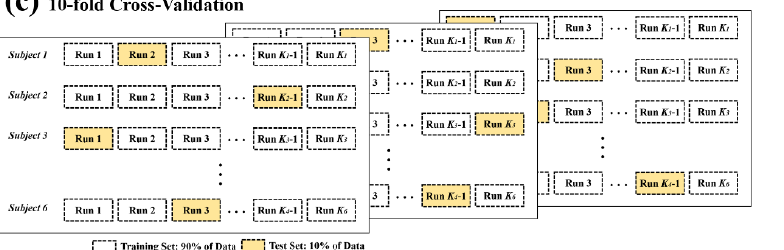
Figure 4. Data separation. ( a ) Within-subject validation was used to train and evaluate the individual classifiers on the attentive and resting states. One run was used for the test set, and the remaining runs were used for the training set. This process was repeated K times, and the test set was switched every time. The accuracy was averaged over K repetitions. ( b ) Cross-subject testing was performed. The data from one subject were used as a training set, and the data from the other 5 subjects were used as a test set. This process was repeated for each of subjects. ( c ) A generic classifier was evaluated using 10-fold cross-validation. The complete dataset from all subjects was collected and randomly split into a test set (10%) and a training set (90%). This process was repeated 10 times, with a different training set and a different test set each time. The accuracy was averaged over 10 repetitions. 3. Results 3.1. Classification Results The ESN had a single readout that indicated whether the subject was in an attentive state or a resting state. Because the attentive state was labeled 1 and the resting state was labeled -1, positive readout values were classified as an attentive state, and negative values were classified as a resting state. The classification performance was evaluated using three cross-validation schemes: Within- subject validation, cross-subject validation, and 10-fold cross-validation. Parameter optimization was performed by averaging accuracies obtained from 10 iterations of the grid search. First, individually